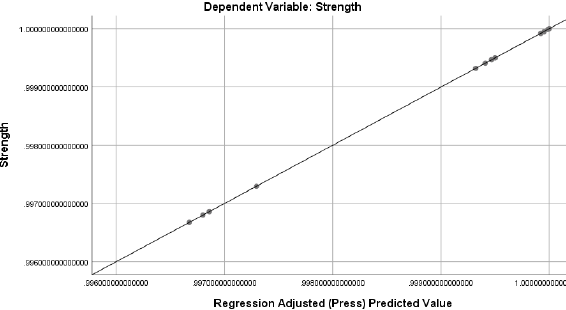
Figure 5: Regression adjusted for Dependent Variable Strength Table 7: Independent Variable Importance